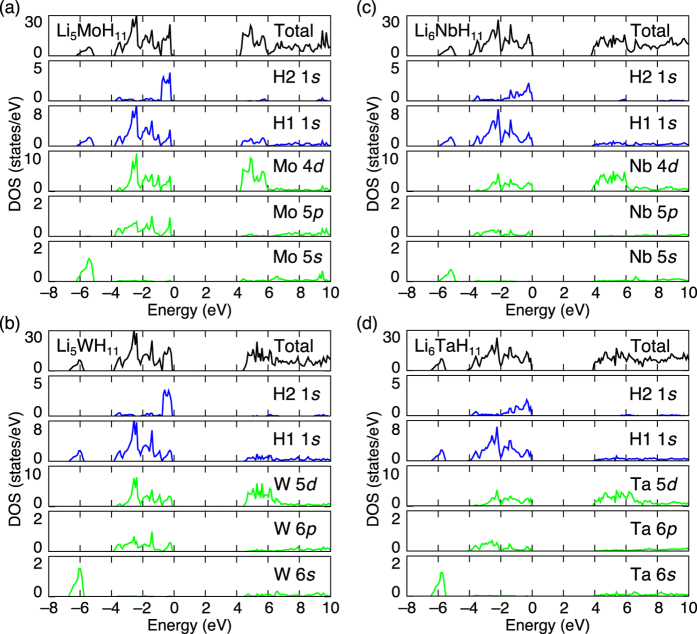
Electronic structures.Total electronic density of states (DOS; top panels) and H2 1s (second panel from the top), H1 1s (third panel from the top), T d (third panel from the bottom), T p (second panel from the bottom) and T s (bottom panels) projections for Li5MoH11 (a), Li5WH11 (b), Li6NbH11 (c) and Li6TaH11 (d). The energy zero is set at the valence-band maximum.